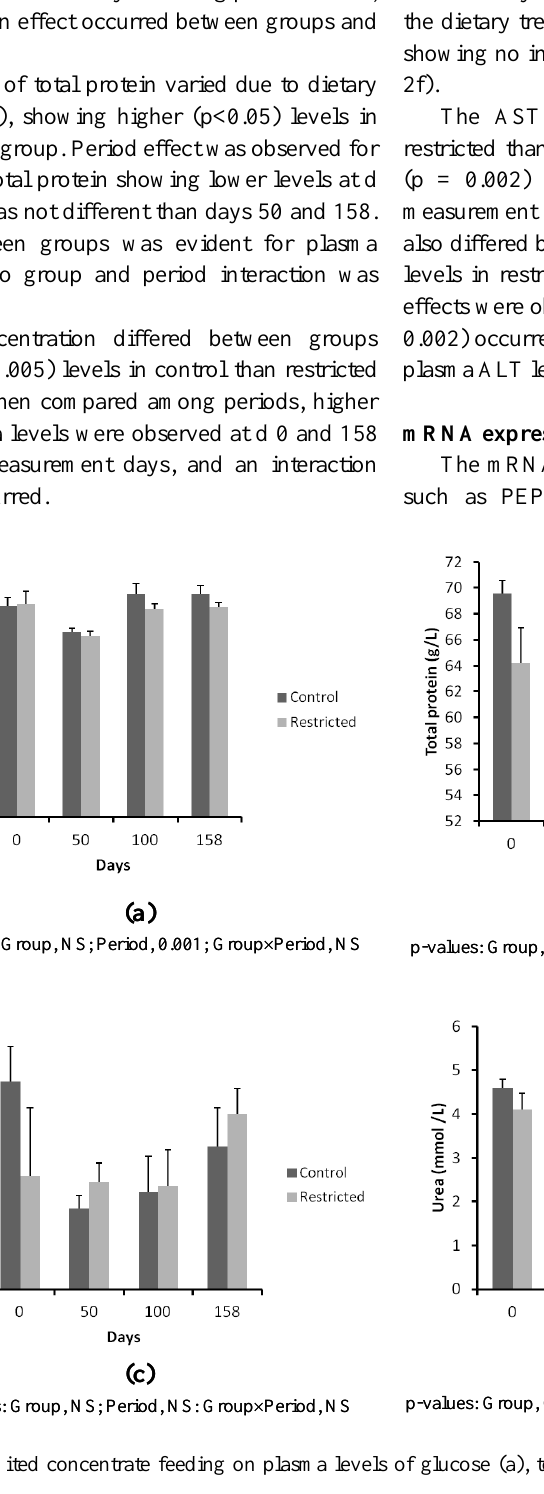
Figure 2. i) Effect of limited concentrate feeding on plasma levels of glucose (a), total protein (b), albumin (c), and urea (d). NS, not